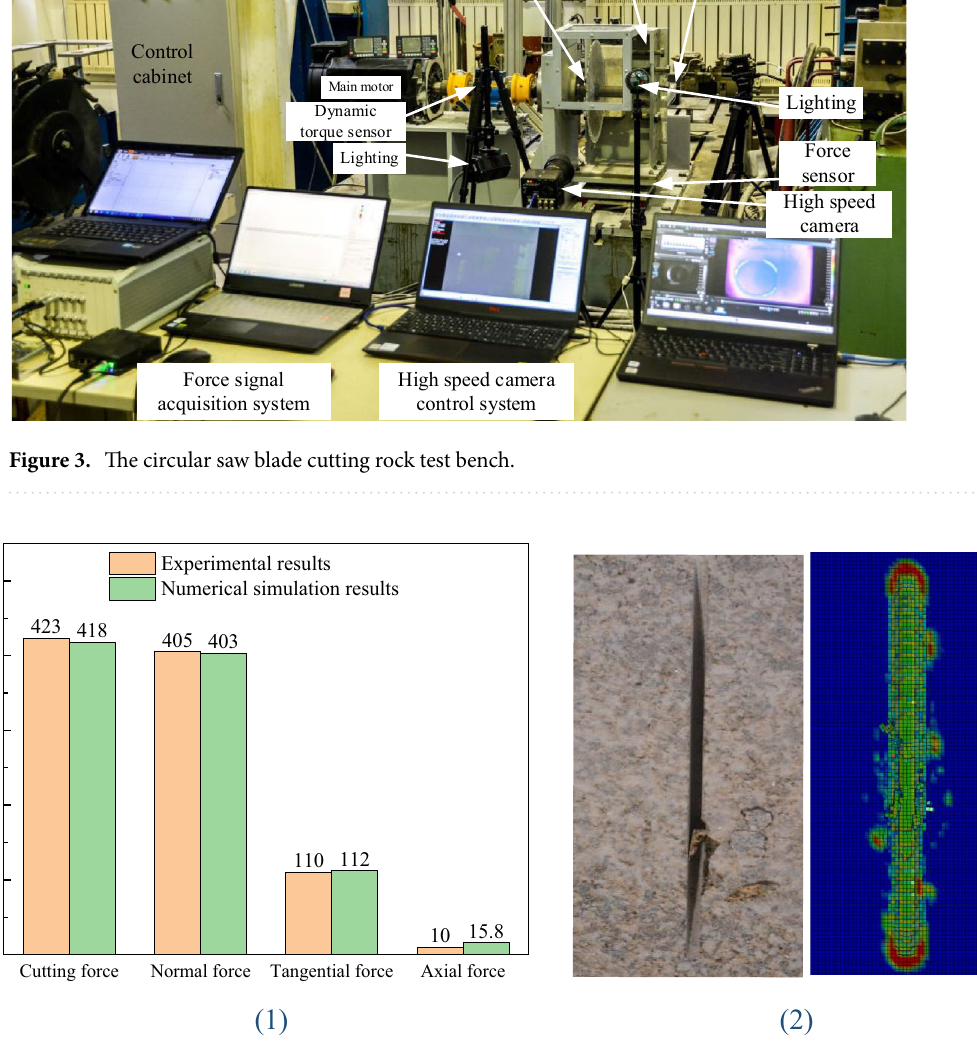
Figure 4. The experimental results of circular saw blade cutting